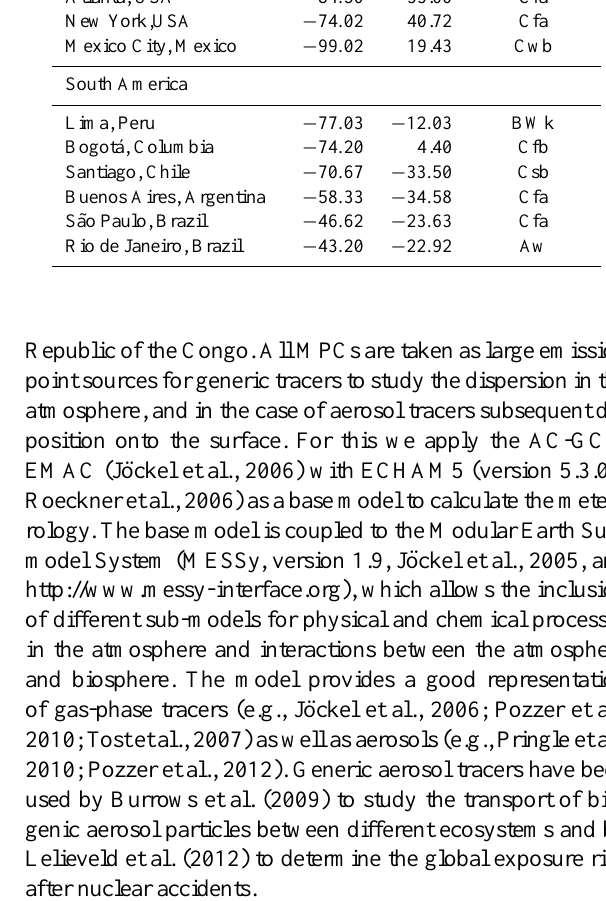
Table 1. Name, location, and climate class of all MPCs used as urban point sources. Longitude and latitude correspond to the model grid box with tracer emissions. DRC=Democratic Repub- lic of the Congo, RC=Republic of the Congo, PRC=People’s Republic of China, ROK=Republic of Korea. Climate classes from Peel et al. (2007): Am=tropical, monsoon; Aw=tropical, savannah; BWh=arid, desert, hot; BSk=arid, steppe,